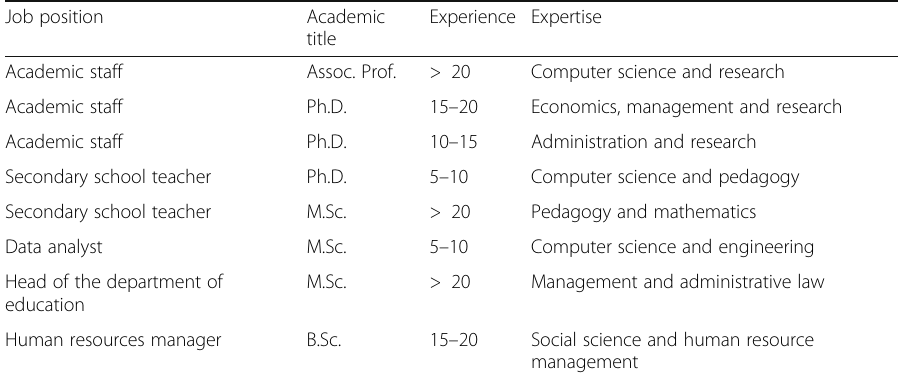
Table 1 Experts ’ qualifications participated in the Delphi process Job